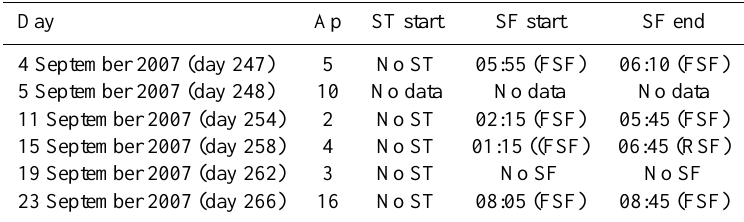
23 September 2007 (day